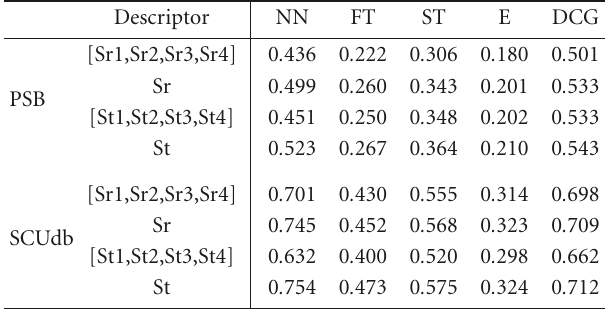
Table 7: Retrieval statistics for univariate and multivariate density- based